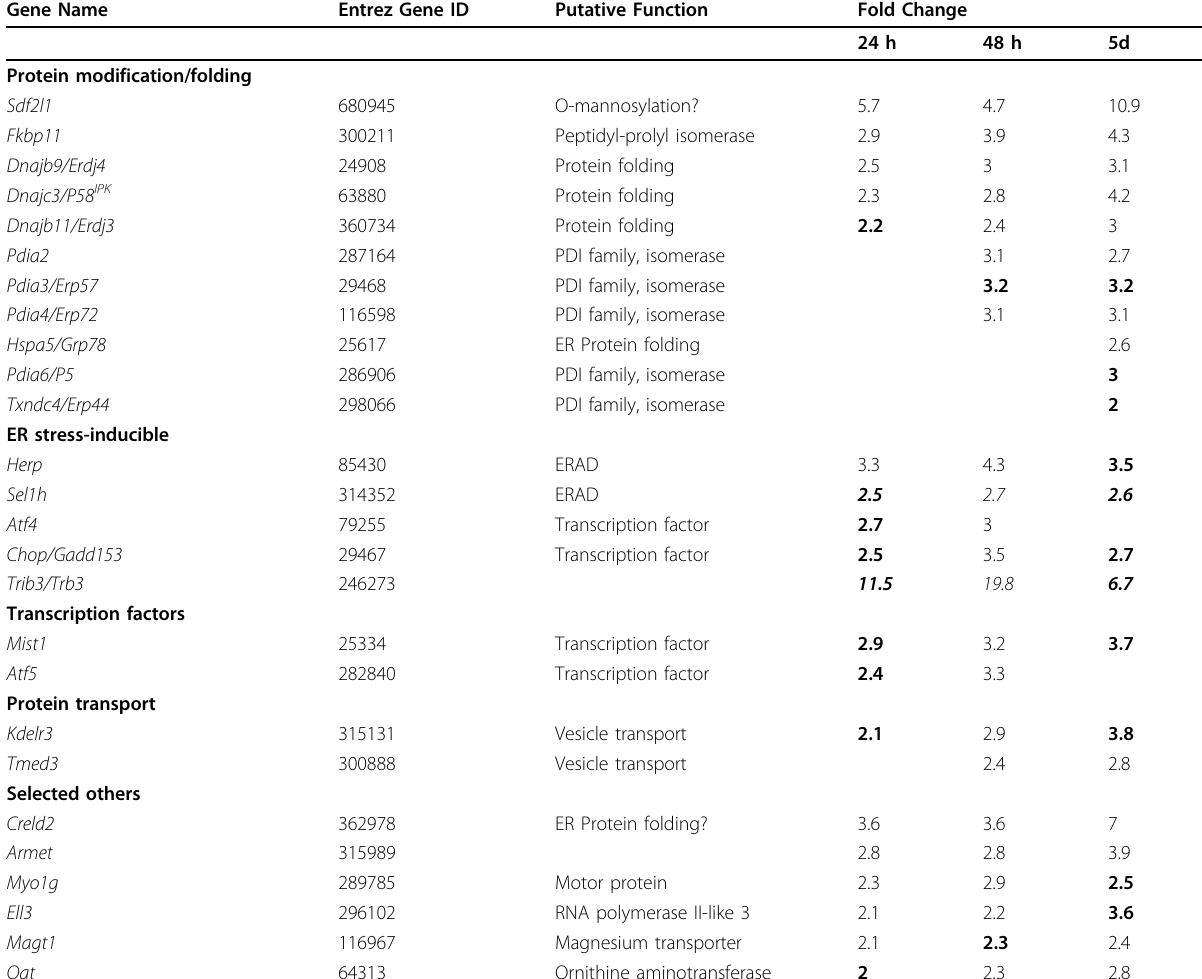
Table 1 Selected list of induced genes comparing uninduced cells to cells expressing insulin 2 (C96Y)-EGFP for 24 h, 48 h and 5 days identified by Affymetrix rat genome